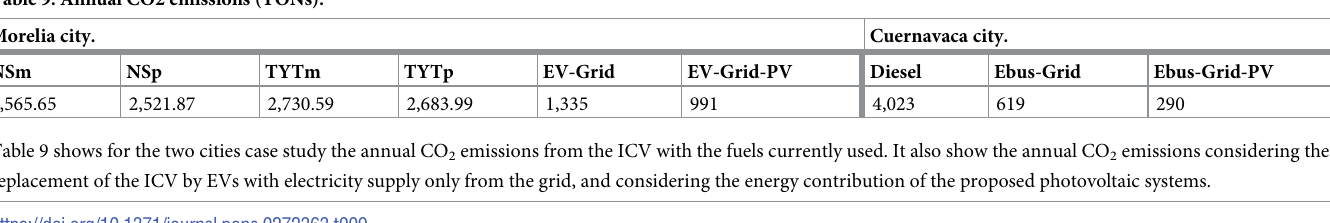
Fig 4. Comparison CO 2 emissions ICV vs electric and PV alternatives for Morelia and Cuernavaca cities. https://doi.org/10.1371/journal.pone.0272363.g004 As can be seen in the graph, driving a Toyota Hiace vehicle using magna gasoline implies a cost of $28,568 USD per year and $28,927 for driving a Nissan Urvan using premium gasoline. Driving a Mercedes Benz bus in Cuernavaca city represents an annual cost of $22,075 USD. EV electricity cost per km. According to the energy price in Mexico, using Eq 6 the EV cost per kilometer was calculated. Costs per km for both cities are shown in Table 12. Comparison ICV vs EV costs. Electric Vehicles (EVs) have fewer moving parts than internal combustion vehicles (ICVs); they do not need oil changes or filters. The powertrain of Table 9. Annual CO2 emissions